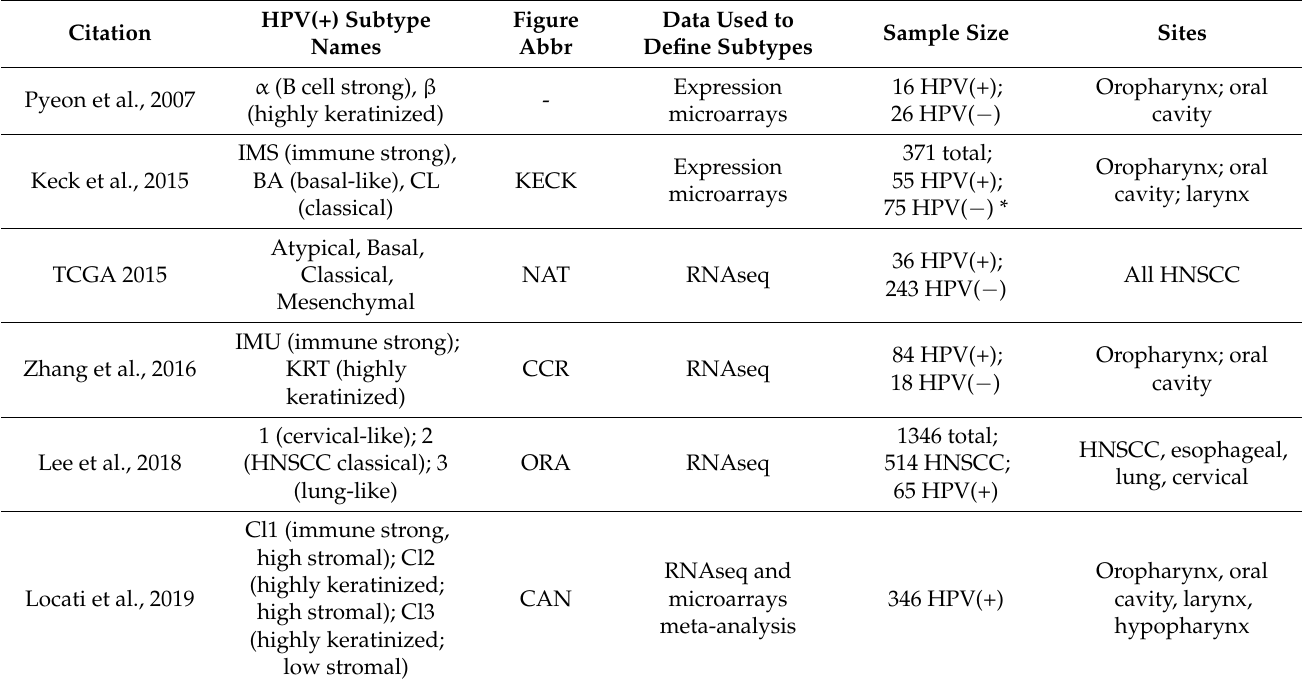
Table 1. Gene Expression Studies that Defined HPV(+) HNSCC